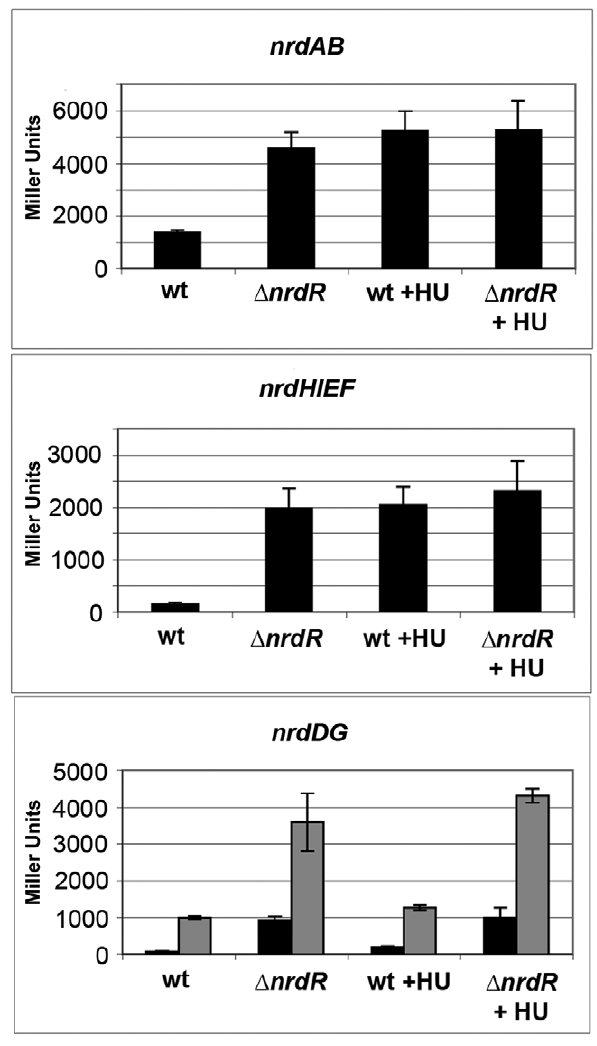
Figure 3. Hydroxyurea-dependent expression of RNR. Effect of hydroxyurea on nrdAB , nrdHIEF and nrdDG expression of wild-type and D nrdR mutant strains. b -galactosidase activity is expressed in Miller Units (MU). Overnight cultures of each strain were reseeded and grown for 1 hour previous to inoculation with 10 mM hydroxyurea. nrdDG fusion strains were grown either in aerobiosis (in black) or anaerobiosis (in grey). Results are the mean values of duplicates of at least three independent experiments. Error bars represent the standard deviation of experiments.